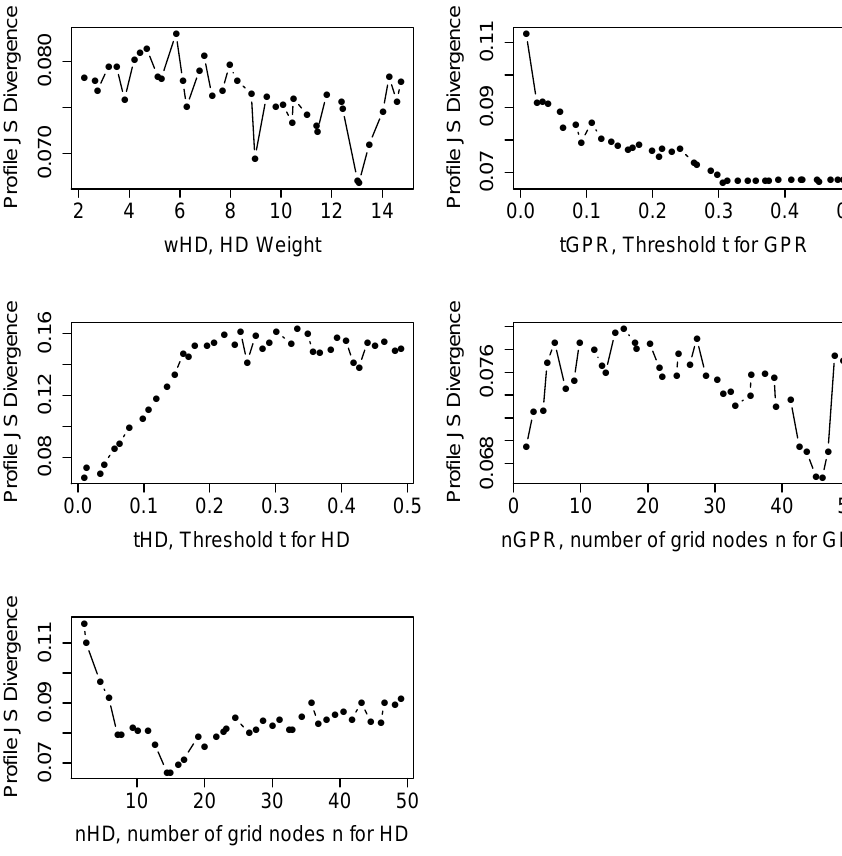
Figure 10. Profile JS divergences as a function of 5 DS input